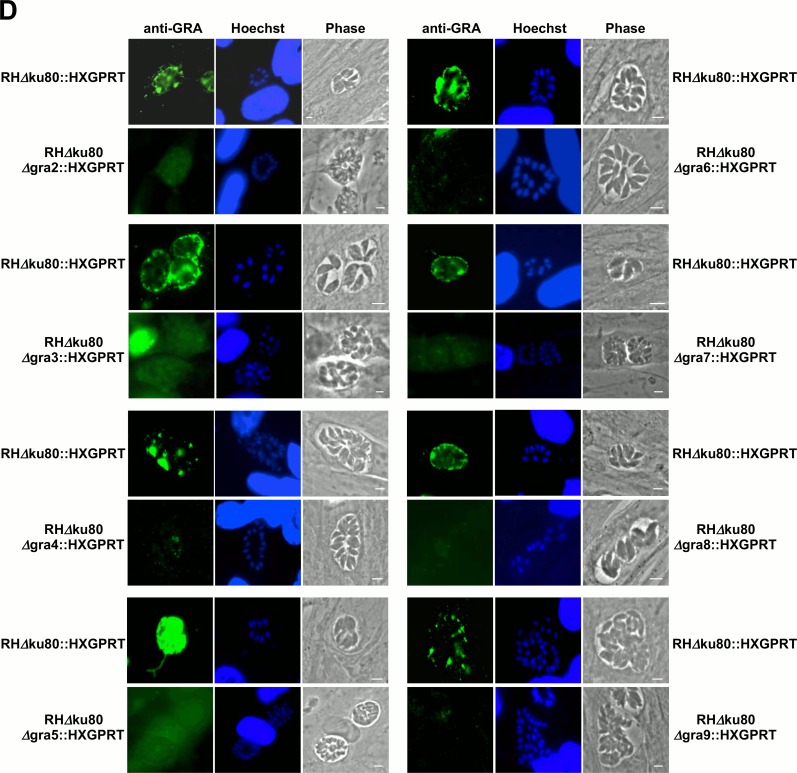
Indirect immunofluorescence assay verifies deletion of GRA proteins.IFA validation of the deletion of GRA2-9. HFFs were infected overnight with Δgra knockout strains or with the parental strain. Infected cells were fixed, permeabilized with 0.002% saponin and incubated with the appropriate primary antibodies (see Material and Methods), followed by Alexa 488-coupled goat anti-mouse IgG or goat anti-rabbit IgG secondary antibodies. After labeling both the host- and parasite nuclei were revealed with Hoechst 33342; coverslips were mounted in Mowiol and observed by epifluorescence. To distinguish the shape of ∆gra mutants’ vacuoles in the absence of fluorescent signal, we chose to artificially increase their exposure time, which may lead to some artificial background noise. Scales: 5 μm.